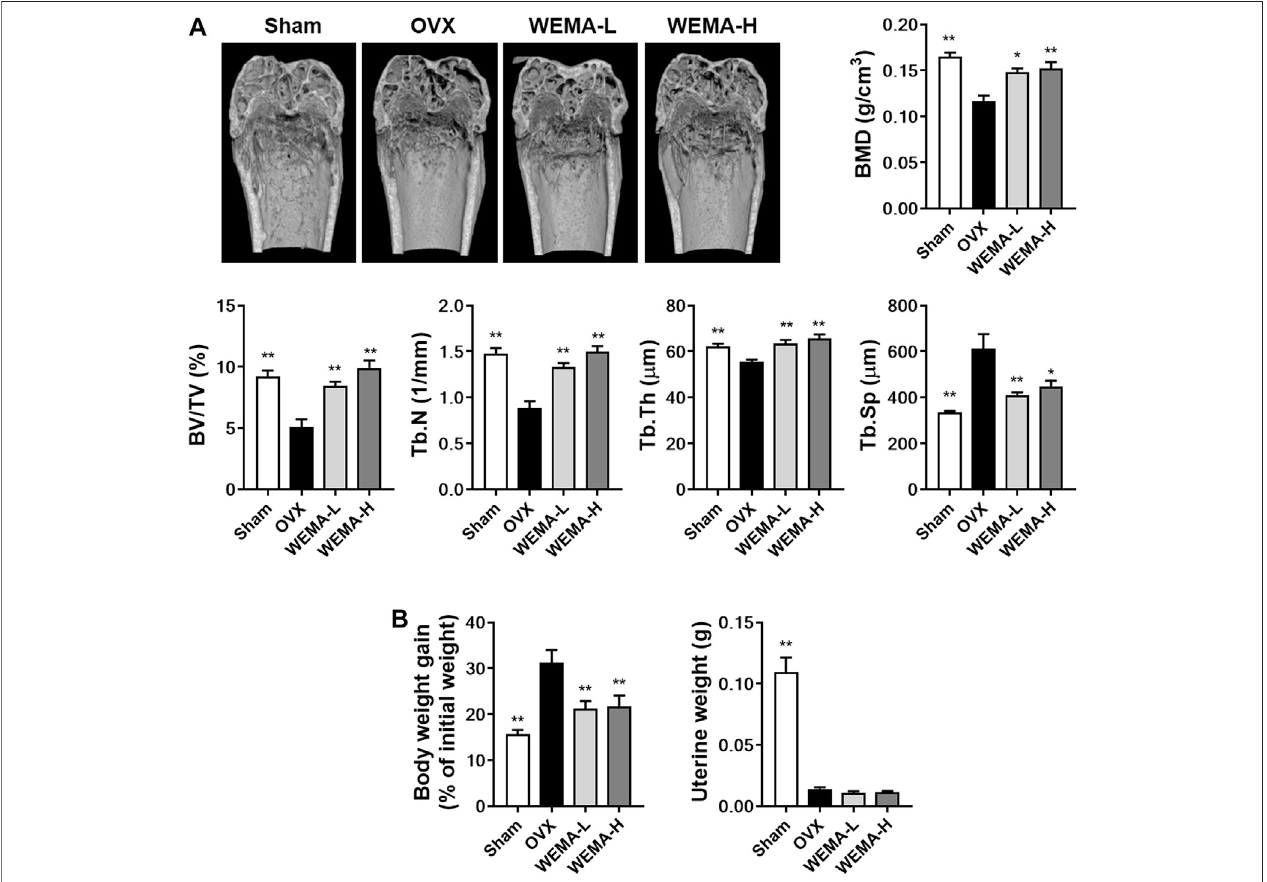
FIGURE 3 | WEMA slowed OVX-induced bone loss in mice. The mice were orally administered vehicle or WEMA for 5 weeks. (A) µ-CT images, BMD, and bone morphometric parameters of femoral trabecular bone. (B) Body weight gain and uterine weight. OVX, ovariectomy group; WEMA-L, OVX + WEMA 100 mg/kg/day